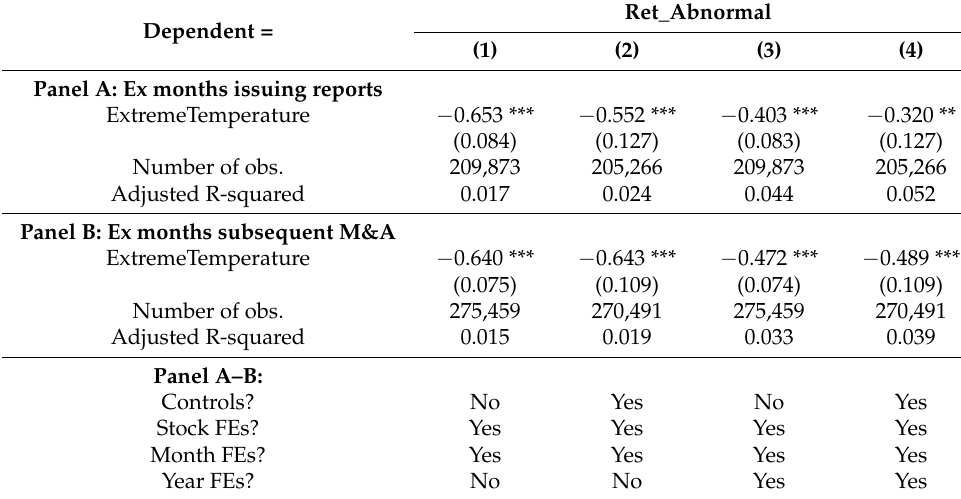
Table 11. Baseline regressions of excluding months with major